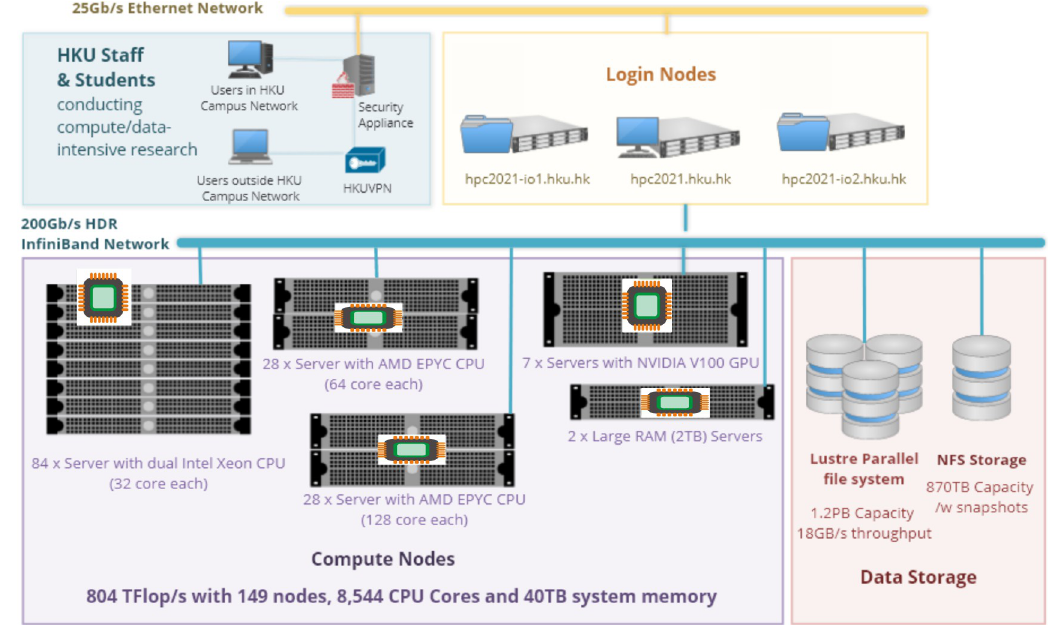
Fig 4. System specification of high-performance computer. Republished from [31] under a CC BY license, with permission from ITS, HKU, original copyright